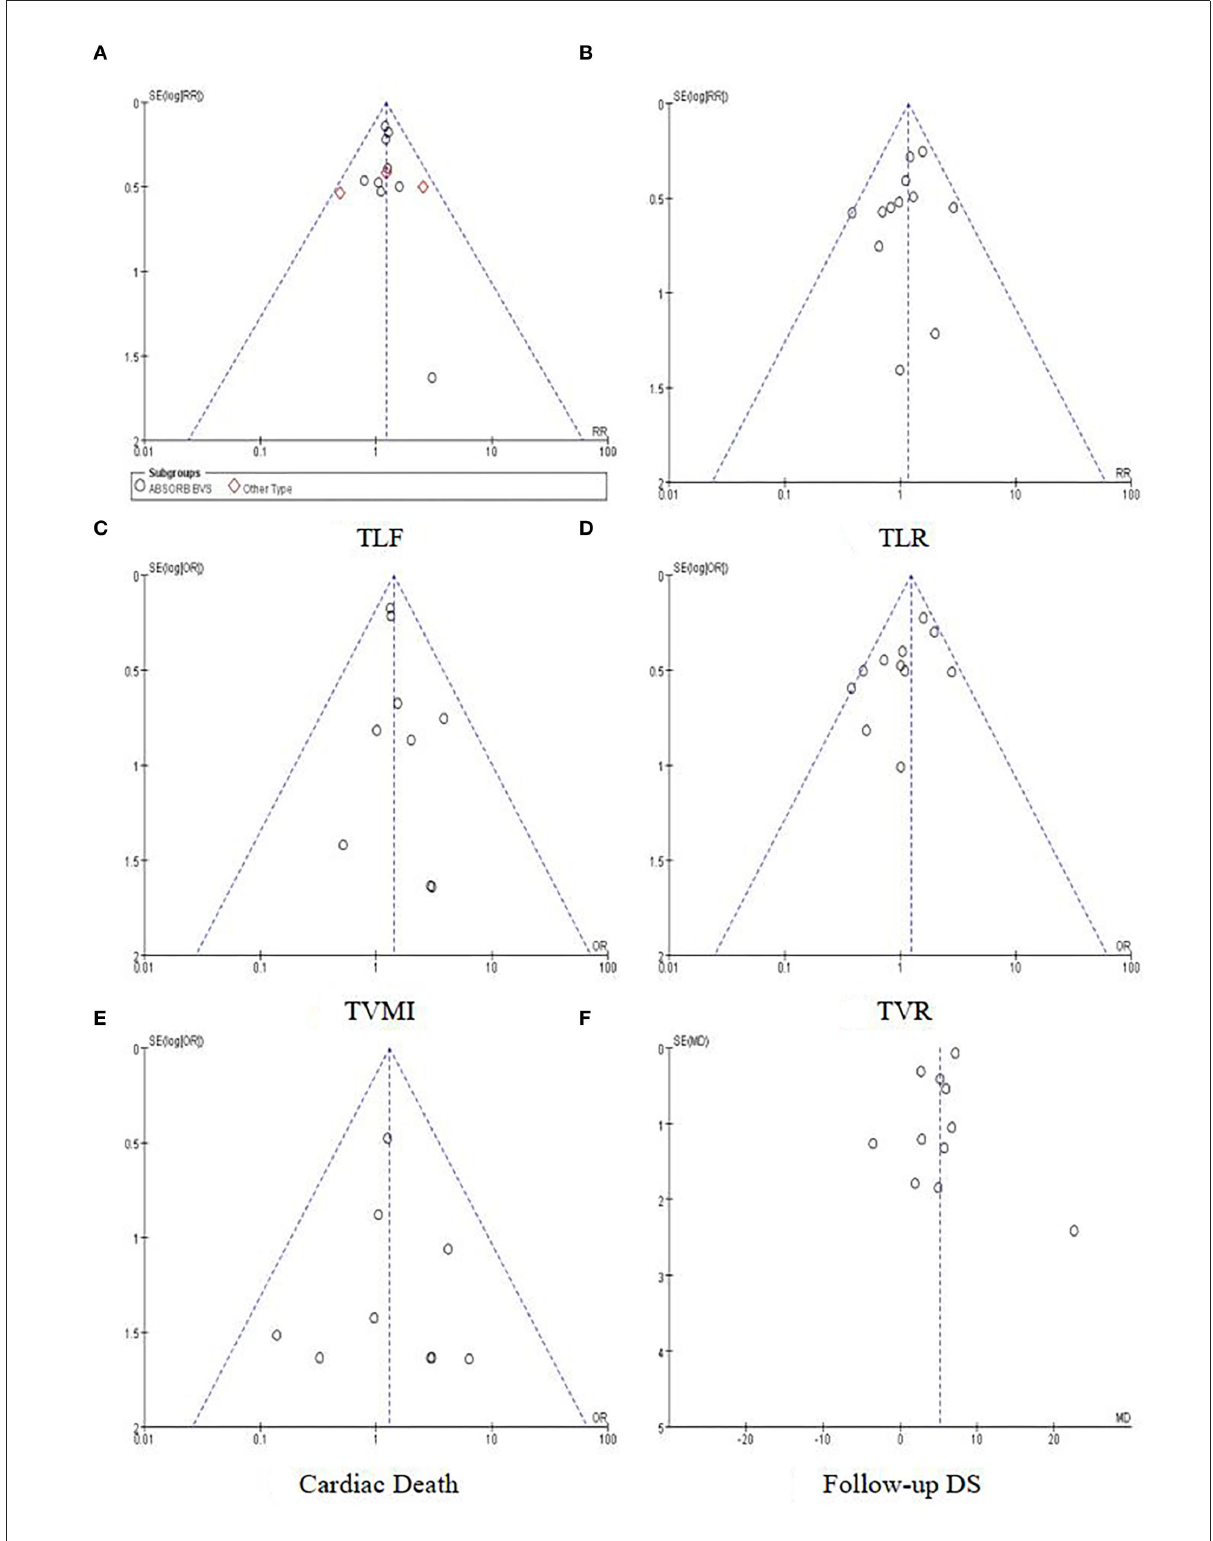
FIGURE3 Funnel plots for outcomes. (A) TLF. (B) TLR. (C) TVMI. (D) TVR. (E) Cardiac death. (F) Follow-up